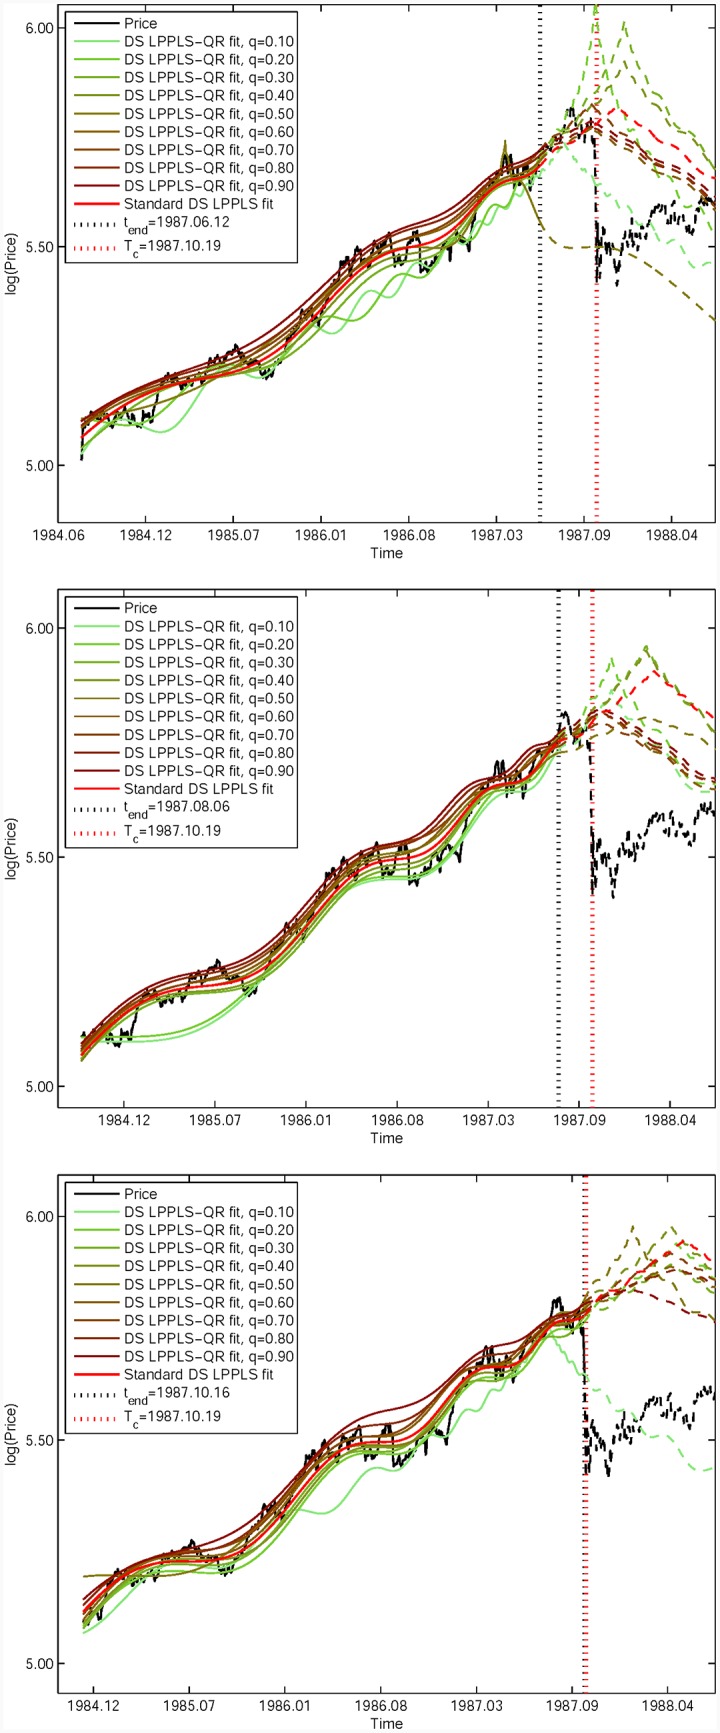
Nine coloured calibrated curves obtained by the method of LPPLS quantile regression for nine different q of the “S&P 500 1987” bubble.(A) Curves in the time window [1984.07.30, 1987.06.12]. (B) Curves in [1984.09.21, 1987.08.06]. (C) Curves in [1984.12.03, 1987.10.16]. The in-sample continuous curves in each panel are extended by dashed out-of-sample lines with the same colours. The noisy black line is the in-sample empirical price time series, followed by the black dashed out-of-sample data. The red thick line is the standard L2-based fitting curve for comparison, which is extended by the red dashed out-of-sample curve. The black dashed vertical line shows the value of tend used in the calibration. The red dashed vertical line gives the true Tc = 1987.10.19.